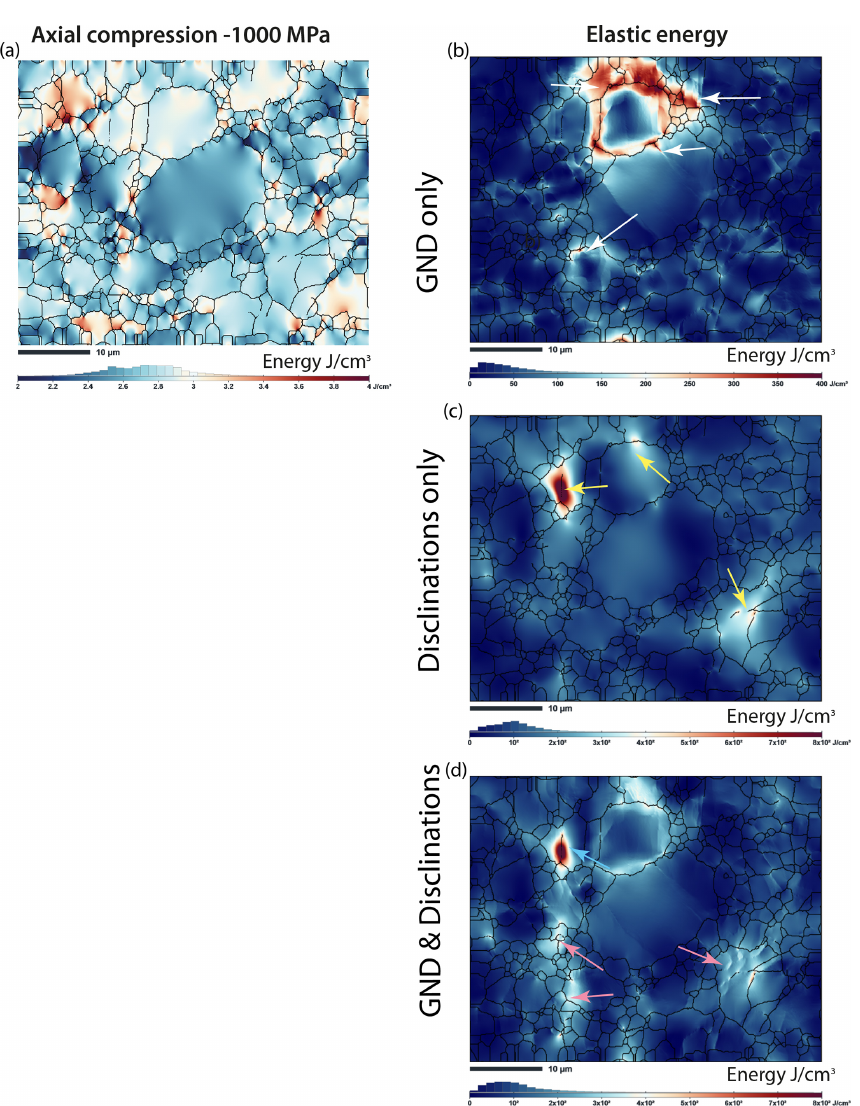
Figure 15. Maps resulting from field dislocation and disclination mechanics (FDDM) simulations of a section of sample CMT-16-9 (a) after axial compression (1000MPa), designed to reveal mechanical incompatibilities from crystallographic orientation in adjacent olivine grains; (b) with no compression, designed to reveal the action of GND only on internal elastic energy; (c) with disclination only on internal elastic energy; or (d) with both GND and disclination on internal elastic